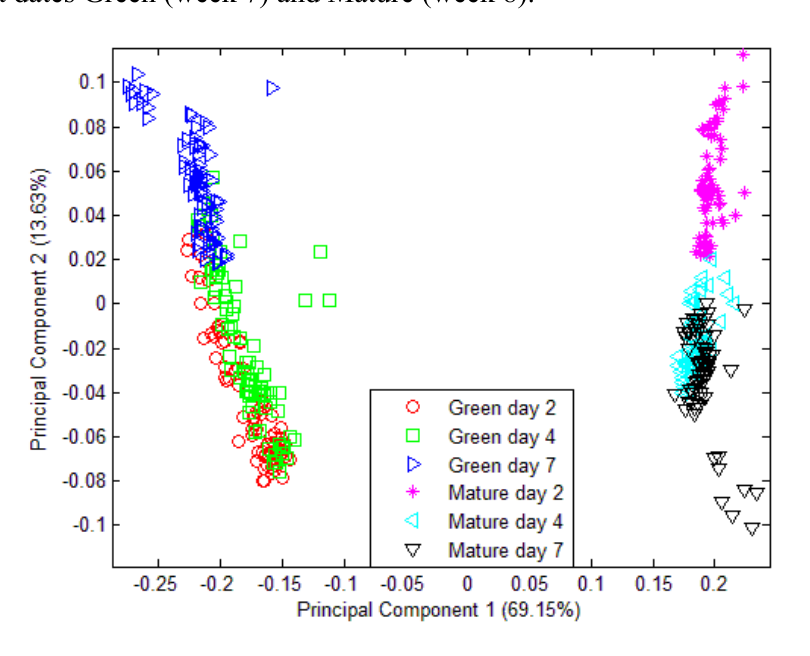
Figure 10. PCA for three different maturity and ripeness level of Harumanis harvested at two different dates Green (week 7) and Mature (week